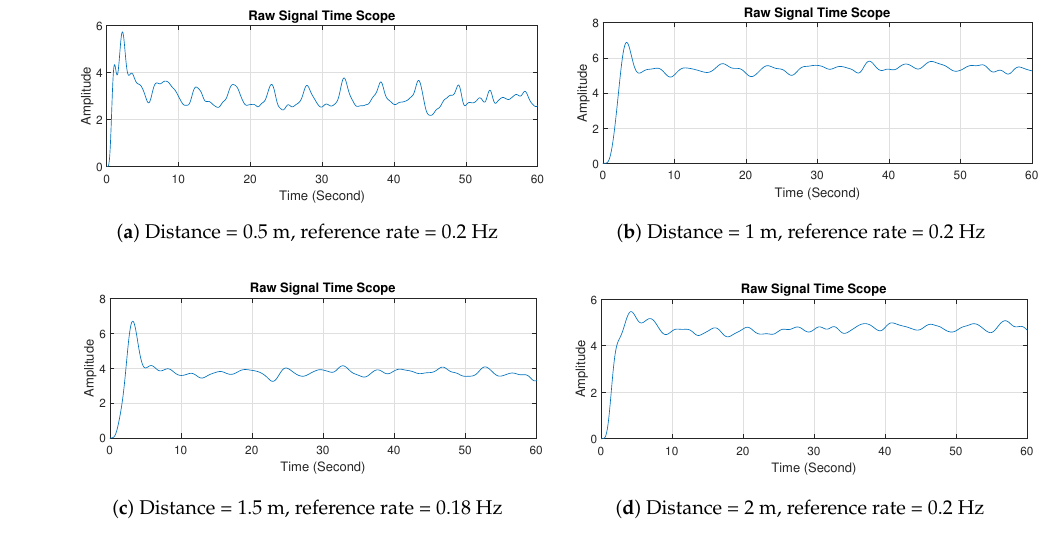
Figure 12. Experiment 2 results in time